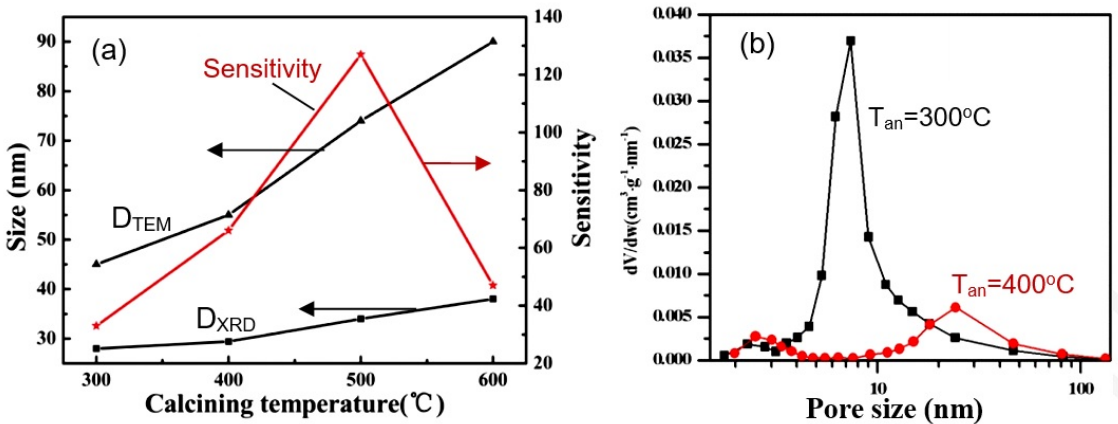
Figure 14. ( a ) Effect of annealing on crystallite size (D TEM and D XRD ) and sensitivity of sensors based on porous ZnO nanoflakes. Reprinted with permission from [62]. Copyright 2011: RSC; ( b ) Pore − size ‐ distribution curves of 3D hierarchical ZnO porous structure after annealing at 300 °C and 400 °C. Reprinted with permission from [120]. Copyright 2015: Elsevier.